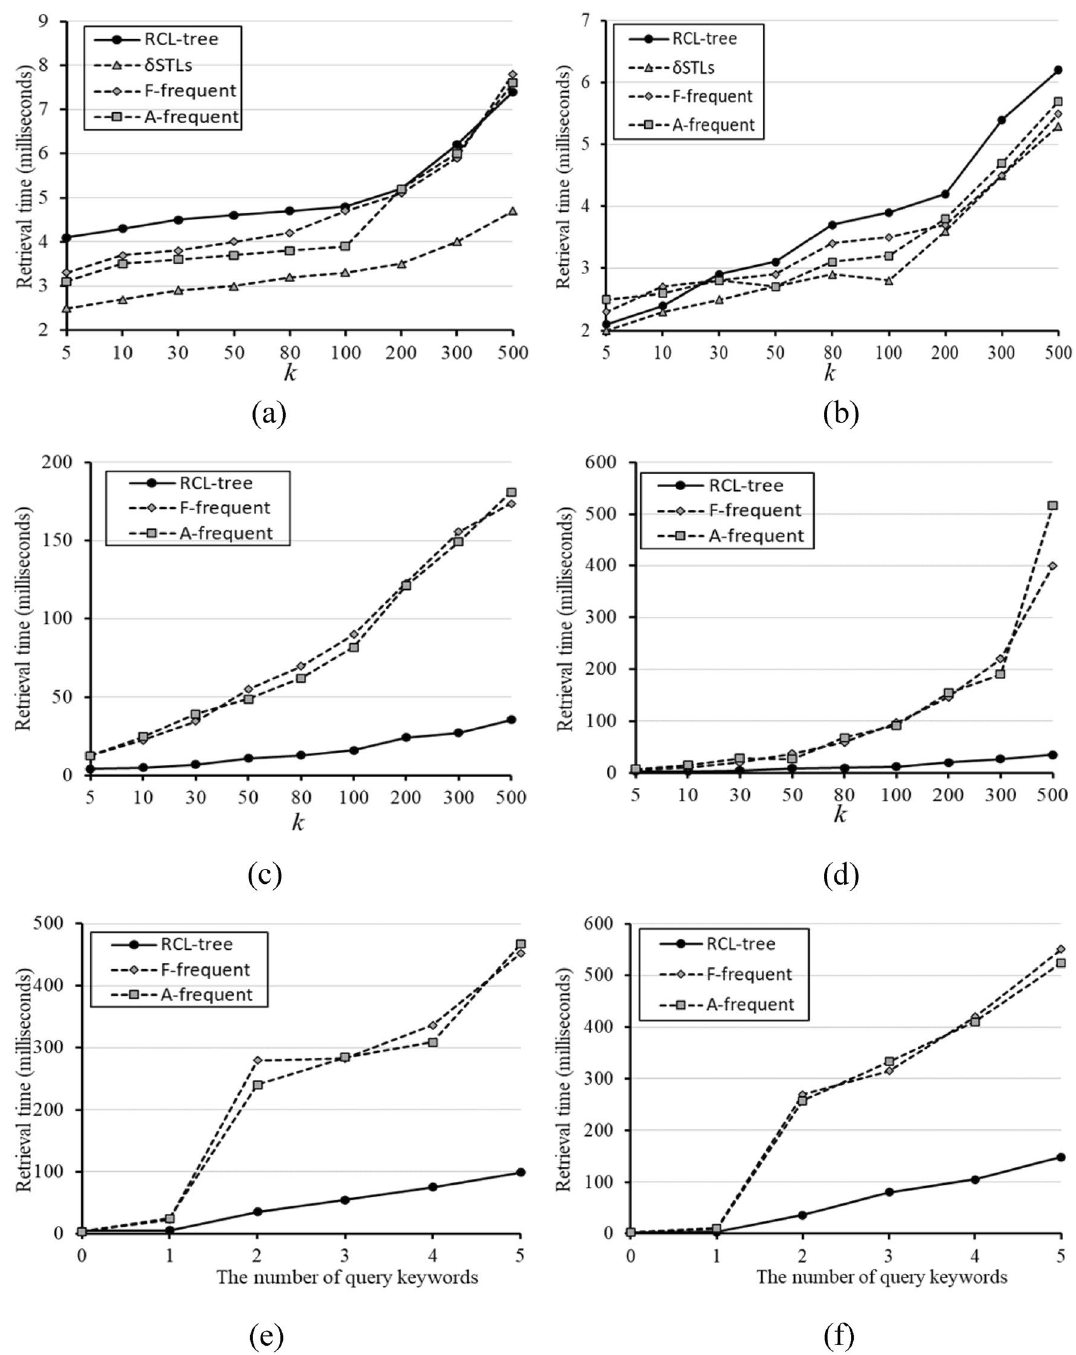
Figure 8. Effect of k and the number of query keywords on retrieval time. ( a ) I Yelp with K . size = 0 , ( b ) I Amap with K . size = 0 , ( c ) I Yelp with K . size = 1 , ( d ) I Amap with K . size = 1 , ( e ) I Yelp with k = 10 , ( f ) I Amap with k = 10 methods. Figure 8a,b show the effect of k with K . size = 0 in I Yelp and I Amap . We can see that δSTLs is still the best method, and RCL-tree is the worst one in most cases. This situation is changed when K . size = 1 . As shown in Fig. 8c,d, A-frequent and F-frequent have the same trends with the increase of k , the performance of RCL-tree is great better than that of A-frequent and F-frequent, and the gap between them grows with the increase of k . When k = 500, the retrieval time of I Yelp is 35.6 ms, which is about 1/5 of A-frequent 173.7 ms and F-frequent 181.1 ms, and I Amap is 35.0 ms, which is about 1/15 of A-frequent 517.0 ms and 1/12 of F-frequent 400.0 ms. Obviously, RCL-tree has more advantages than other methods when K is not an empty set. The detailed analysis about the effect of K on retrieval time with k = 10 and the full data set are shown in Fig. 8e,f. We can see that as the number of query keywords increases, the process of tfSKQ becomes more complex, and the advantages of RCL-tree is more obvious. When the number of query keywords is 5, the retrieval time of I Yelp is 98.8 ms,